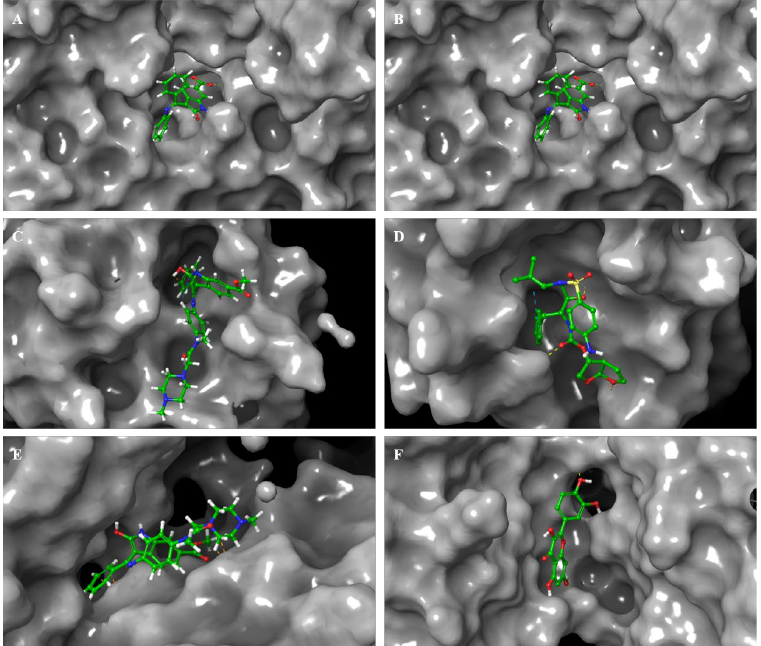
Figure 6. Ligand 3D interactions. ( A , B ): Nintedanib and Baricitinib on ACE2 Protein, PDBID: 6M1D; ( C , D ): Nintedanib and Darunavir on M pro , PDBID: 5R82; ( E ): Nintedanib; ( F ): Quercetin on Spike Protein. PDBID: 1ZV8.